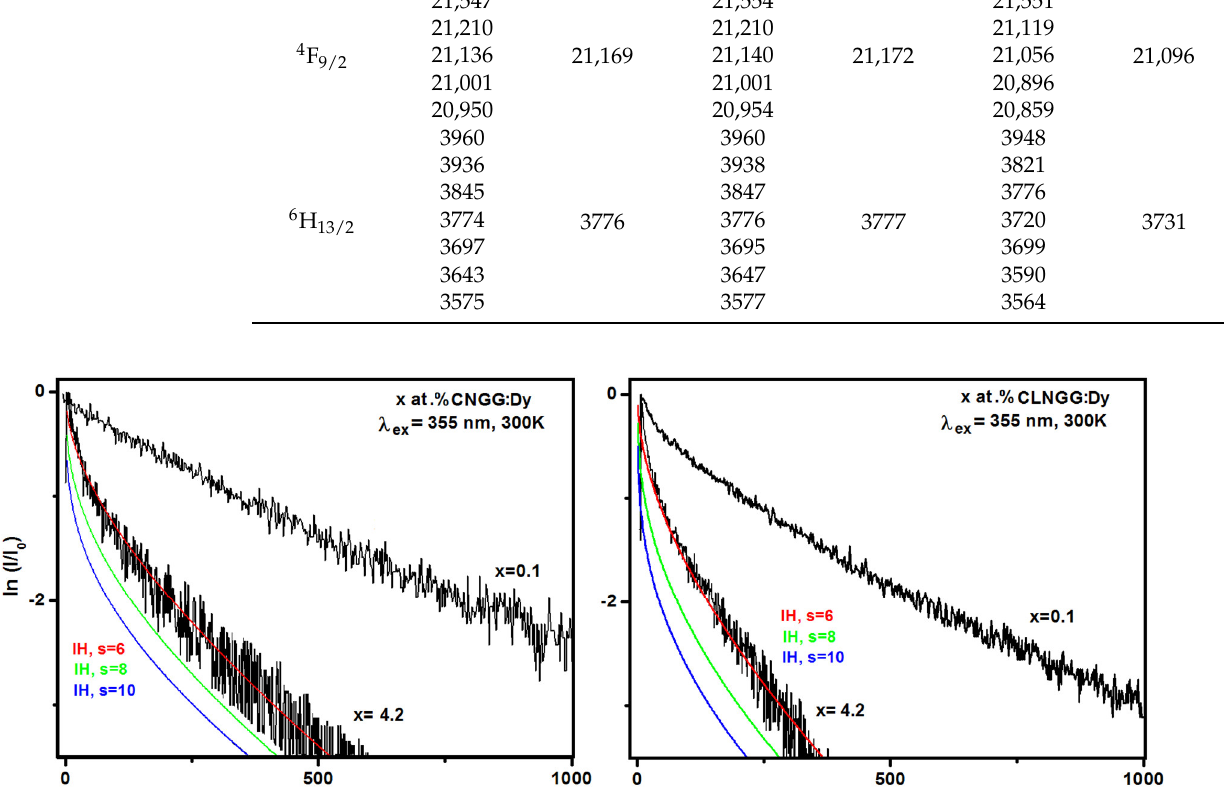
Figure 9. Emission kinetics of the 4 F 9/2 level of Dy 3+ ions in CNGG:Dy ( a ) and CLNGG:Dy ( b ) samples. (Reprinted with permission from Ref. [23], copyright 2018, Elsevier). Table 10. Emission kinetic parameters of the 4 F 9/2 manifold of Dy 3+ ions in CNGG:Dy and CLNGG:Dy crystals.